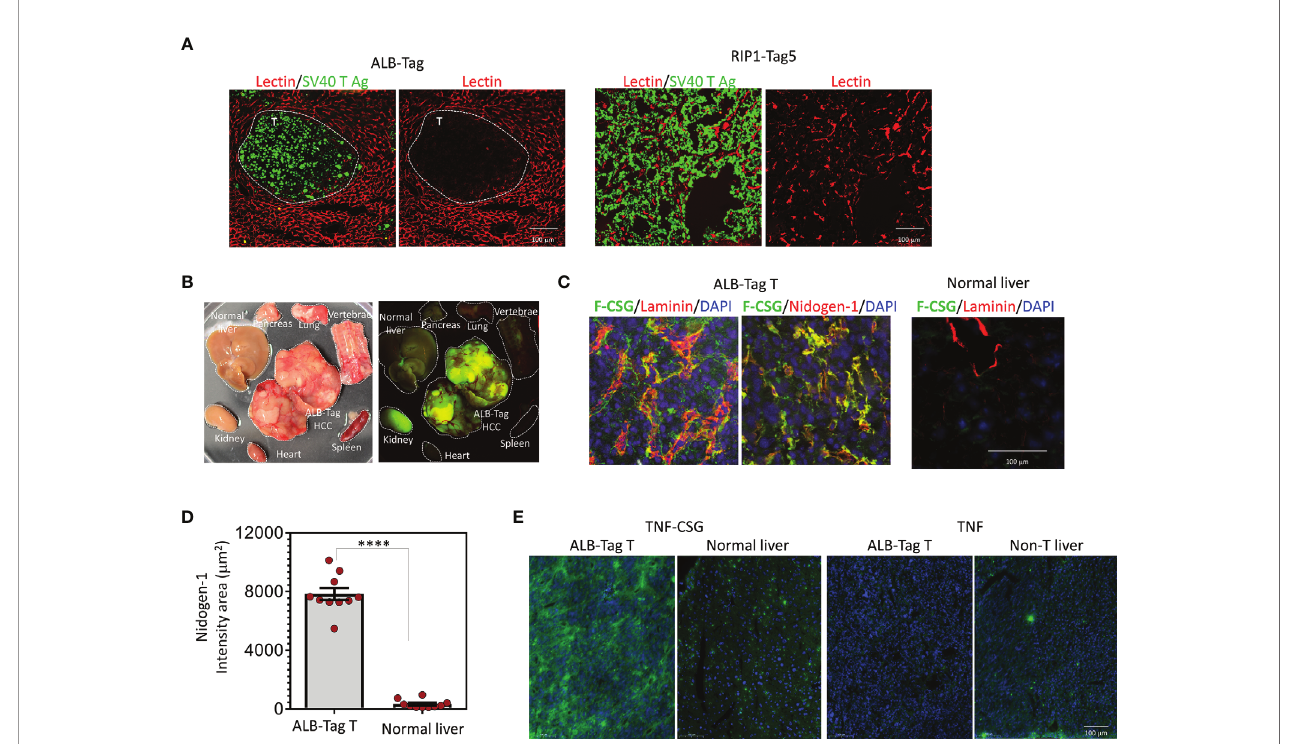
FIGURE 1 | HCC accessibility to lectin and binding speci fi city to CSG peptide and TNF a -CSG. (A) Lycopersicon Esculentum (Tomato) Lectin DyLight ® 594 was injected i.v. in mice bearing ALB-Tag HCC or RIP1-Tag5 tumors. Representative micrographs on indicated tissues show lectin-painted vessels (red) in tumors (T) stained with anti-SV40 Large T antigen antibody (green). (B) Mice bearing ALB-Tag HCC were i.v. injected with 0.1 mmol of FAM-CSG, and tissues were collected after 1 h of circulation. Photographic image of collected tissues under bright light (left) and UV illuminator (right) are shown. Peptide binding is shown in tumors (green) but not in normal tissues. The kidney is the clearance organ. (C) HCC tumors from ALB-Tag mice and normal liver from C3H mice were co-stained for laminin and nidogen-1. Representative micrographs show FAM-CSG binding (green) and laminin or nidogen-1 expression (red). Co-localisation is indicated in yellow. Scale bar 100 µm. (D) Quantitative analysis of nidogen-1 staining per fi eld of each tumor or normal liver, as shown in panel (C) and mean ± SEM (****P < 0.0001 by Student ’ s t -test). (E) Analysis of FITC-TNF a -CSG and FITC-TNF a binding in vivo detected with anti-FITC antibody (green) and nuclear staining (DAPI) in indicated tissues. Scale bars: 25 m